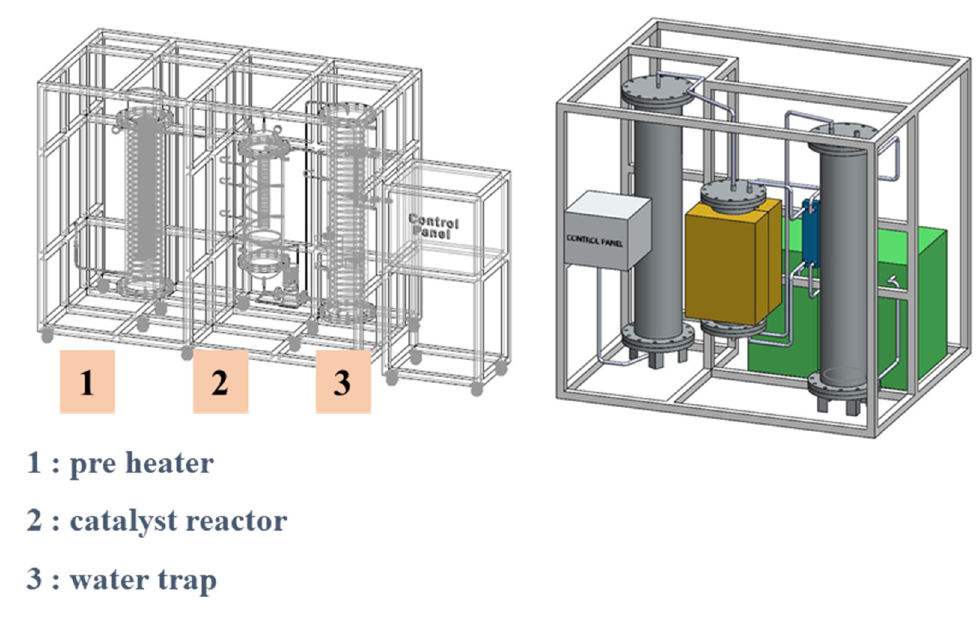
Catalysts 2021 , 11 , x FOR PEER REVIEW Figure 9. Pilot plant of CO 2 methanation in a sewage disposal plant in Korea. Figure 9. Pilot plant of CO 2 methanation in a sewage disposal plant in Korea.